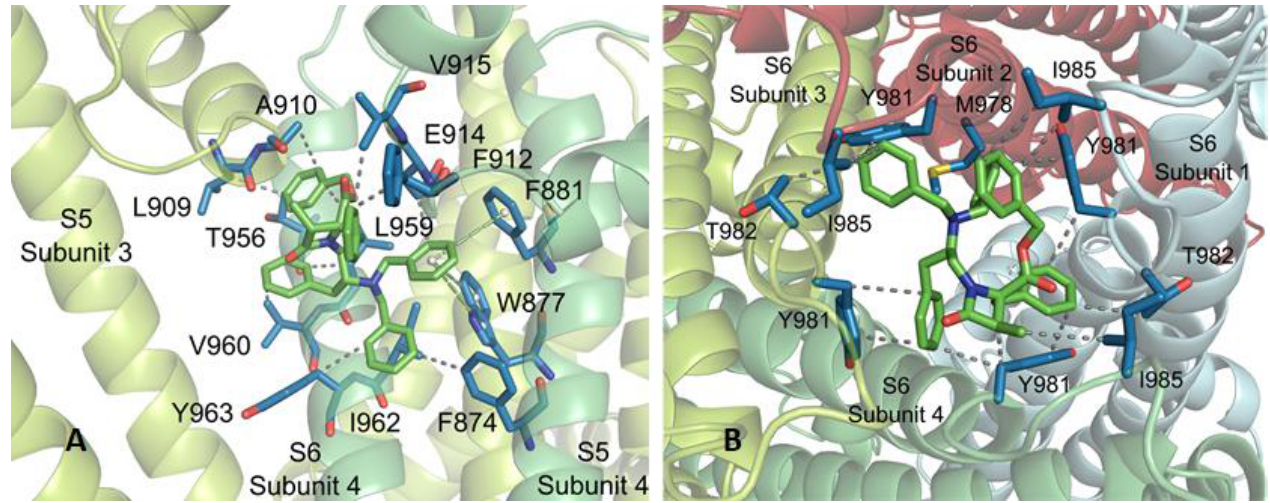
Figure 5. Subsites 1 ( A ) and 2 ( B ) found for β– lactam 16 (carbon atoms in green). WdV interactions are indicated by doted gray lines, and π–π stacking by centroids and non-continuous pale green lines. Channel residues involved in the interactions are shown in blue and labelled.